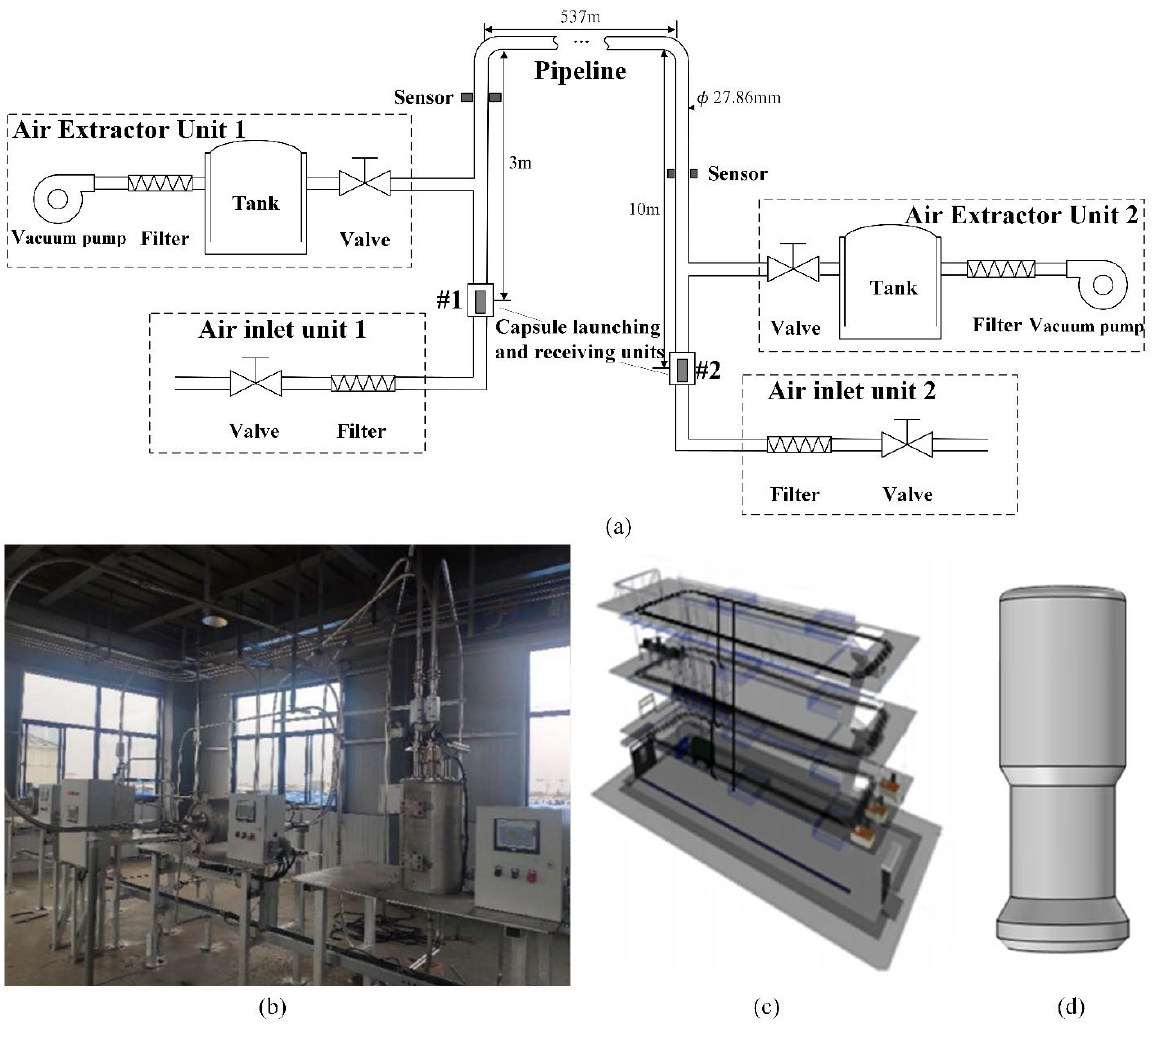
Figure 3. The testing PCP system ( a ) Schematic of the PCP system ( b ) Real view of the PCP system ( c ) 3D architecture of the pipeline ( d ) Configuration of the capsule. ( c ) 3D architecture of the pipeline ( d ) Configuration of the